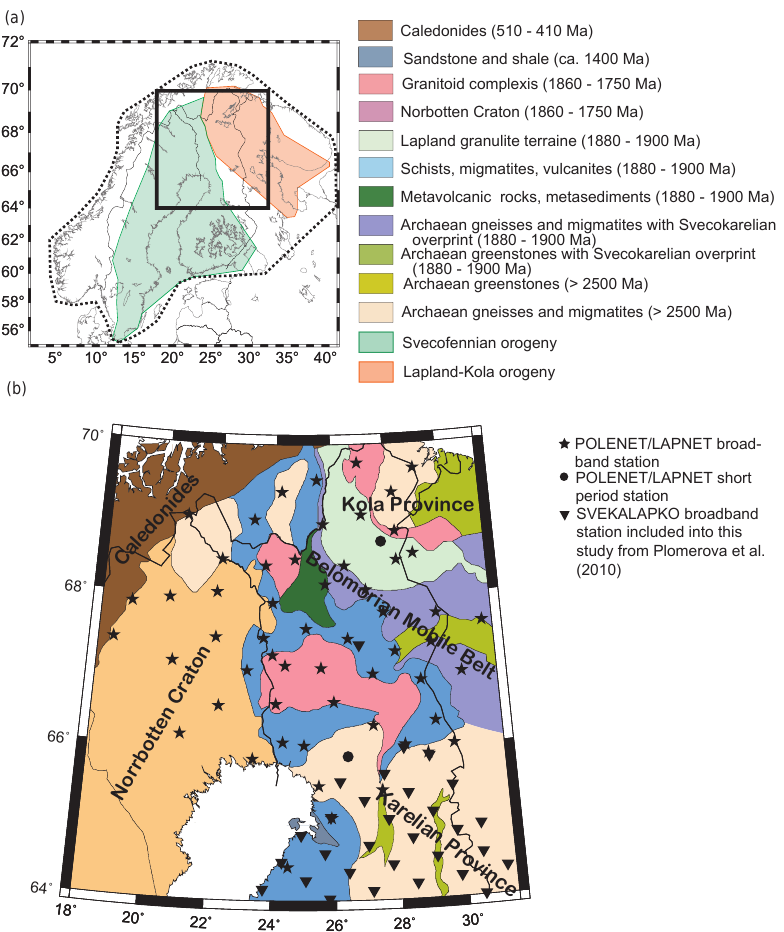
Figure 1. The map of the study area. (a) Simplified map of orogenies based on Lahtinen et al. (2015) in northern Fennoscandia. The Fennoscandian crustal block is outlined by a black dotted line and our study area by a rectangle. (b) The simplified geological map is based on the 1:2000000 geological map of Fennoscandia (Koistinen et al., 2001). The seismic stations are shown with black stars, triangles, and dots, and main geological provinces are